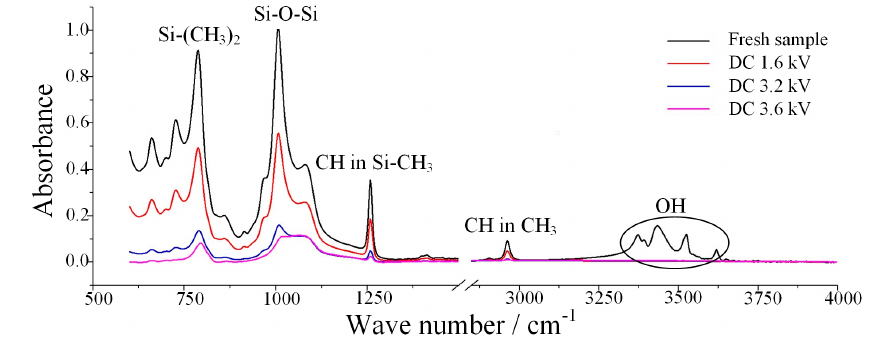
Figure 11. FTIR spectra at di ff erent applied voltages ( γ 20 = 1000 µ S / cm, t = 8 h) Table 8. The absorption peak height of bands in the FTIR spectrum.